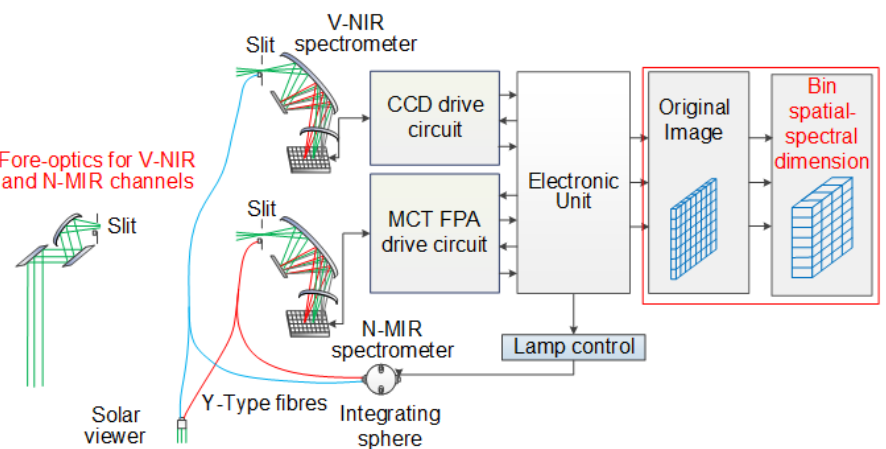
Figure 1. Schematic diagram of the Mars Mineralogical Spectrometer instrument.